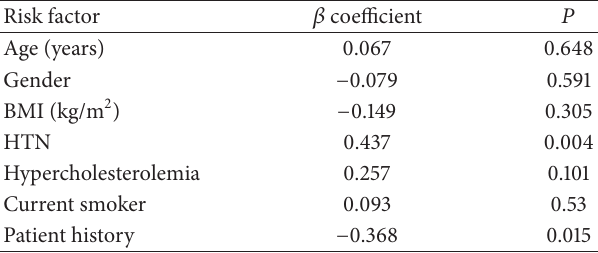
Table 5: Predicting factors for plasma GZB levels in ACS